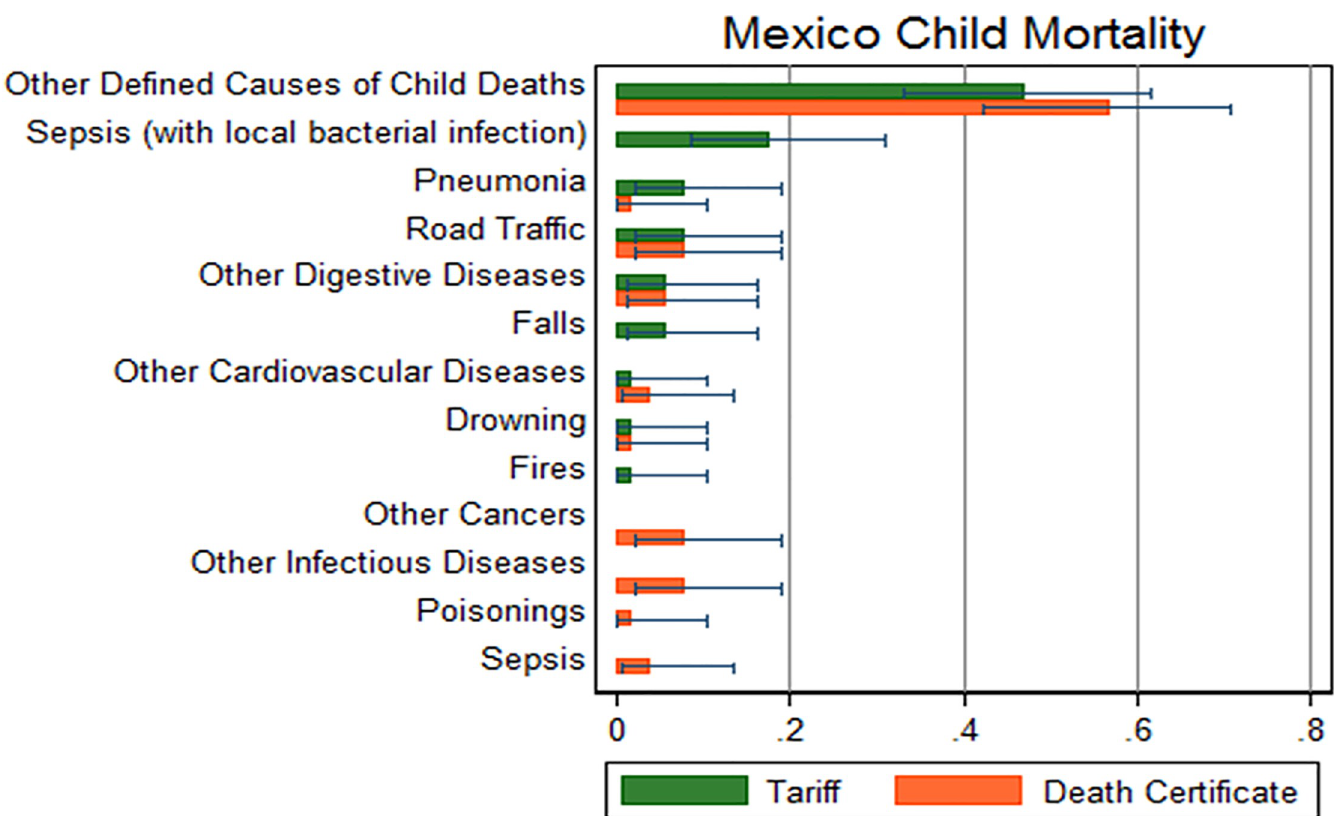
Fig 3. Comparison of child mortality fraction calculated by VAs vs. vital statistics, Hidalgo, Mexico 2009 (n = 1,104).